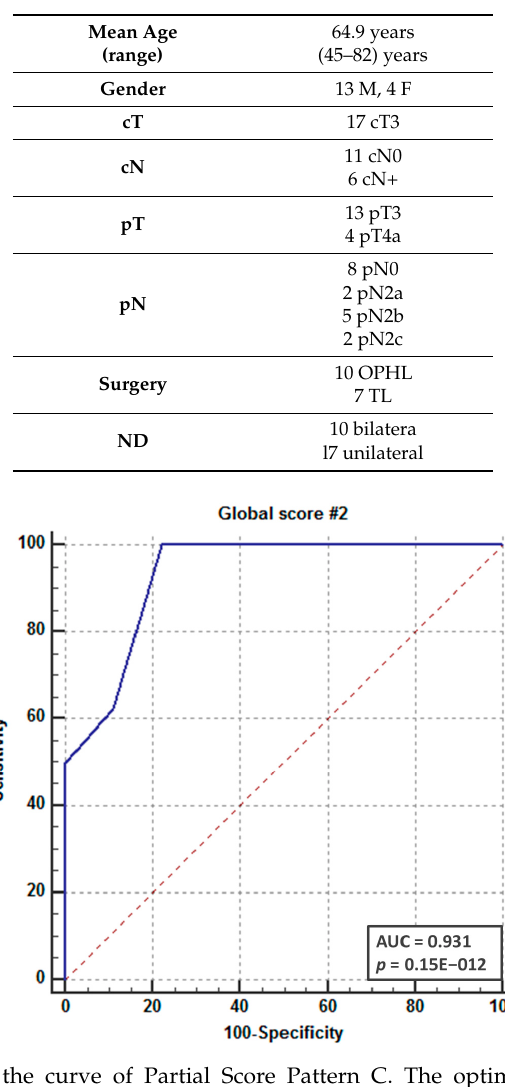
Table 1. Baseline patient, tumor, and surgical procedure characteristics. Legend: OPHL, open partial